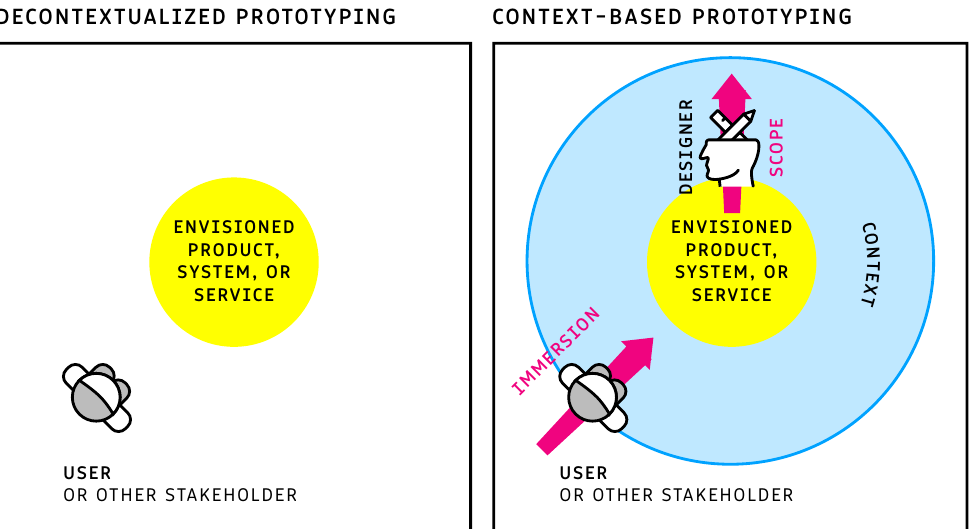
Figure 1. Decontextualized prototyping vs. context-based prototyping. Adapted illustration based on the original diagram of Hoggenmüller [16]. Context-based prototyping situates the envisioned product, system, or service in the context of use. As a result, it increases users’ and other stakeholders’ immersion and the scope of designers and researchers